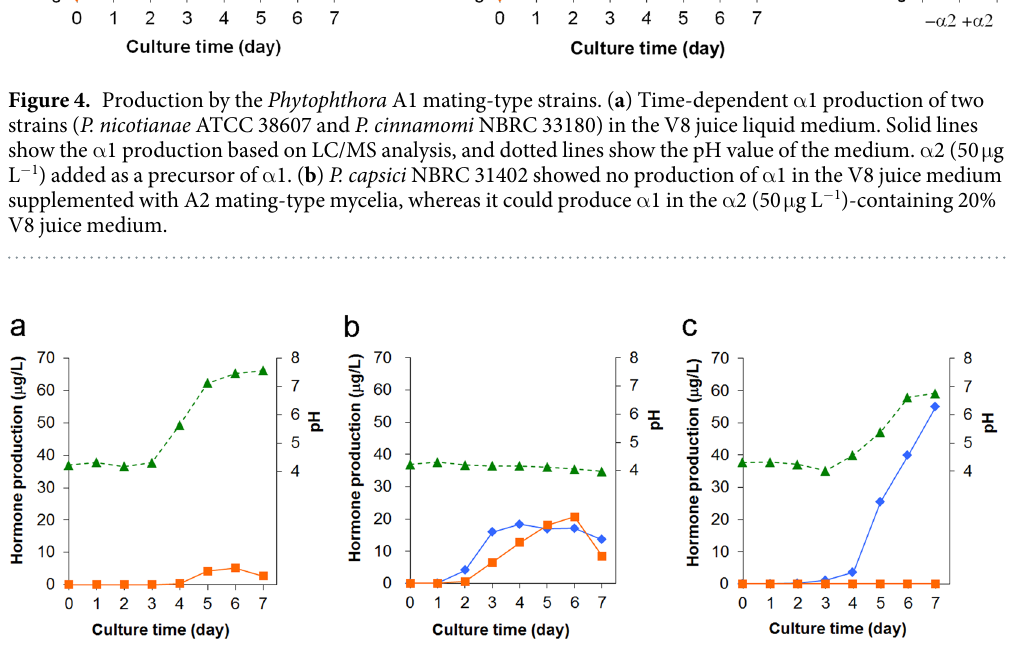
Figure 5. Time-dependent mating hormone production of Phytophthora A2 mating-type strains in V8 juice liquid medium. ( a ) A conventional A2 mating-type strain ( P. nicotianae NBRC 33190) that produced only α 2 from phytol. ( b and c ) Exceptional A2 mating-type strains that produced both hormones ( b) , P. capsici NBRC 8386), or only α 1 ( c , P. cryptogea NBRC 32326). Solid lines with diamond and square labels show the α 1 and α 2 production, respectively, based on LC/MS analysis. Dotted lines show the pH